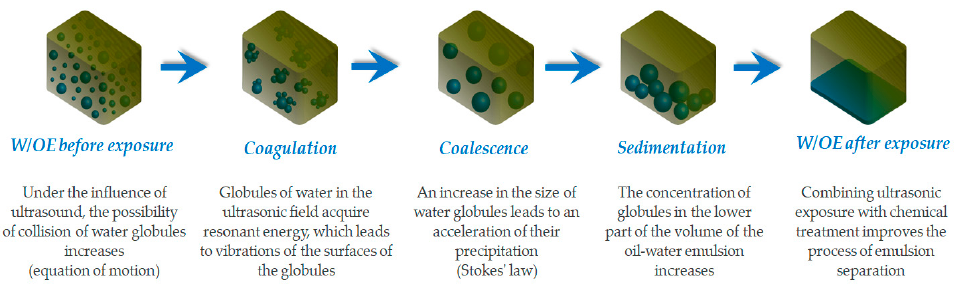
Figure 1. The scientific basis of the technology of accelerated phase separation of water-in-oil emulsions using ultrasonic exposure.